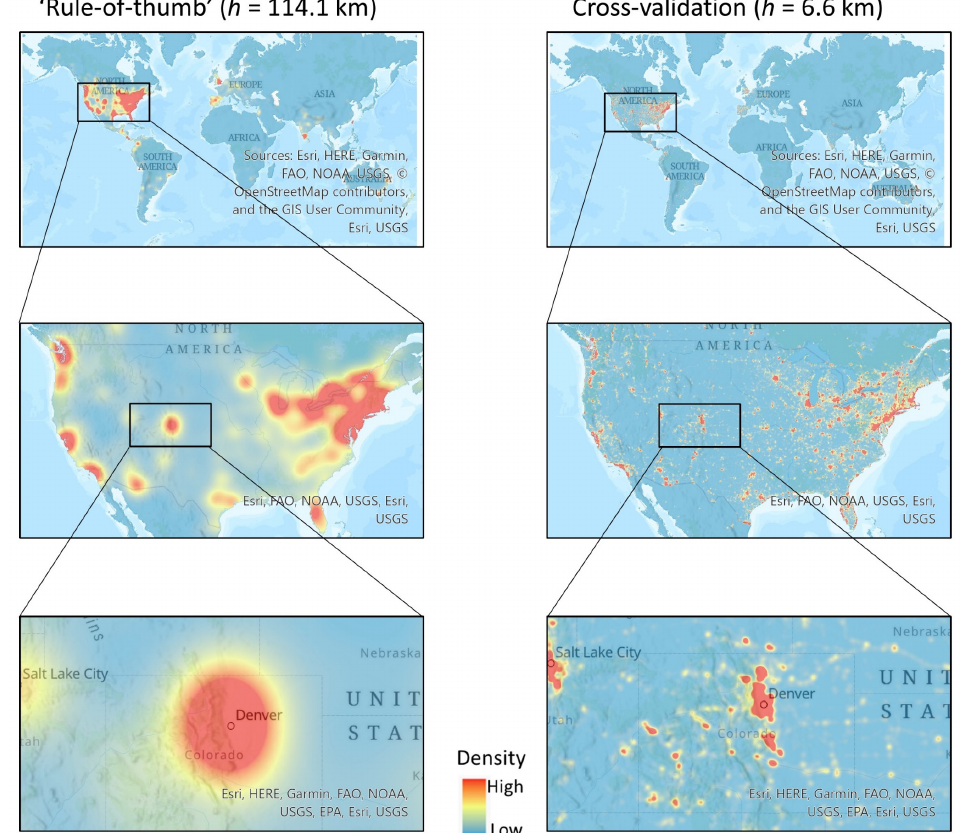
Figure 9. Density maps estimated with fixed bandwidth determined through the ‘rule-of-thumb’ method and through cross-validation on the eBird dataset between ( n = 13,806,513 points; density raster cell size = 1 km).